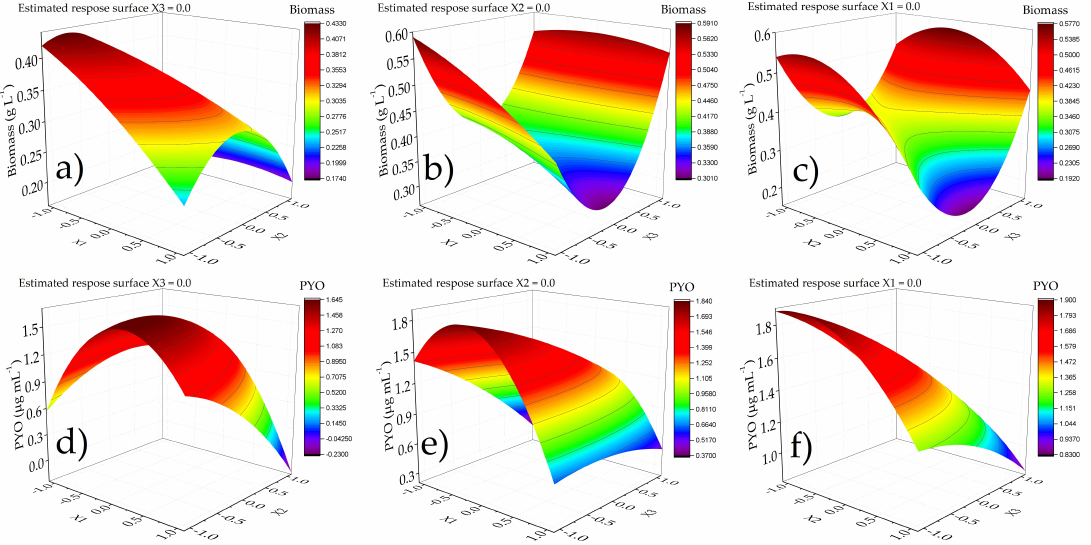
Figure 2. Response surface plots for biomass and PYO production estimated from regression equation in statistical analysis. ( a ) Interaction between temperature and pH; ( b ) interaction between temperature and agitation rate; ( c ) interaction between pH and agitation rate; ( d ) interaction between temperature and pH; ( e ) interaction between temperature and agitation rate; ( f ) interaction between pH and agitation